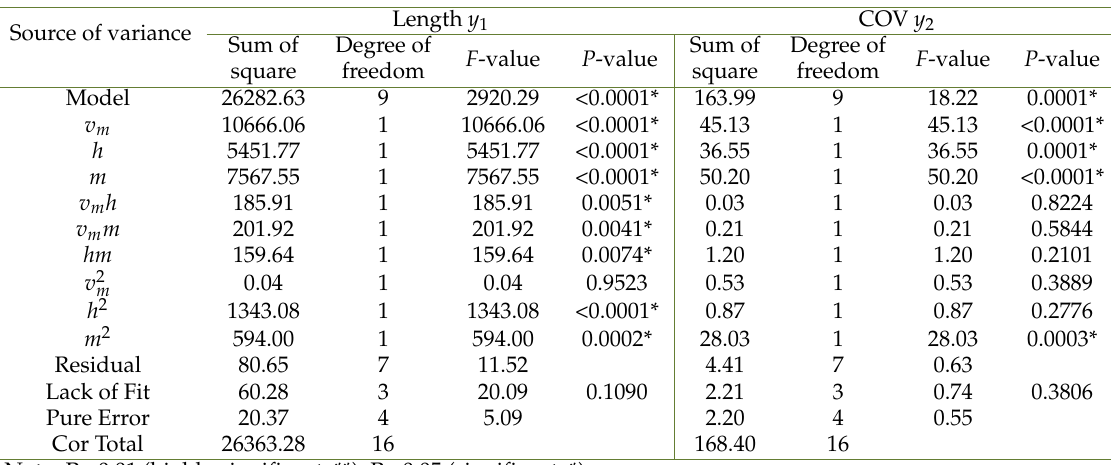
Table 4. Analysis of variance